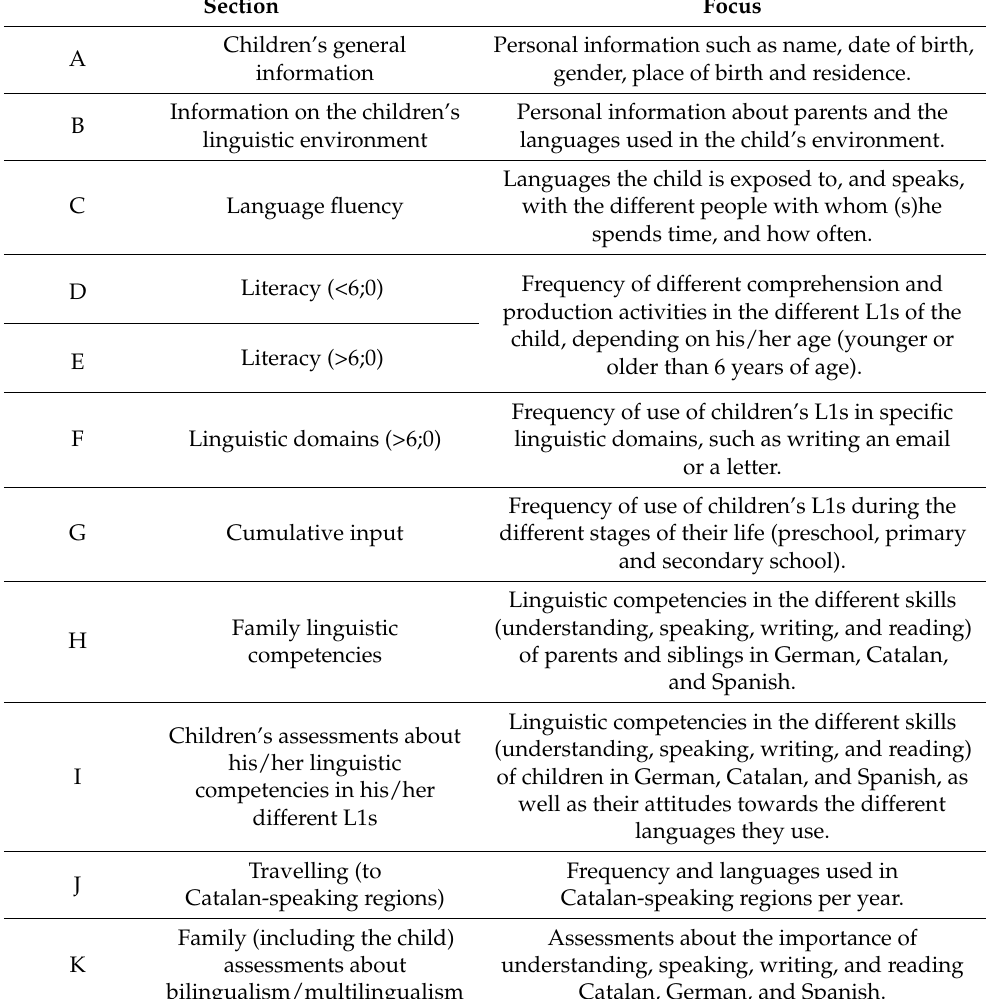
Table 2. Sections and their focus from the parental